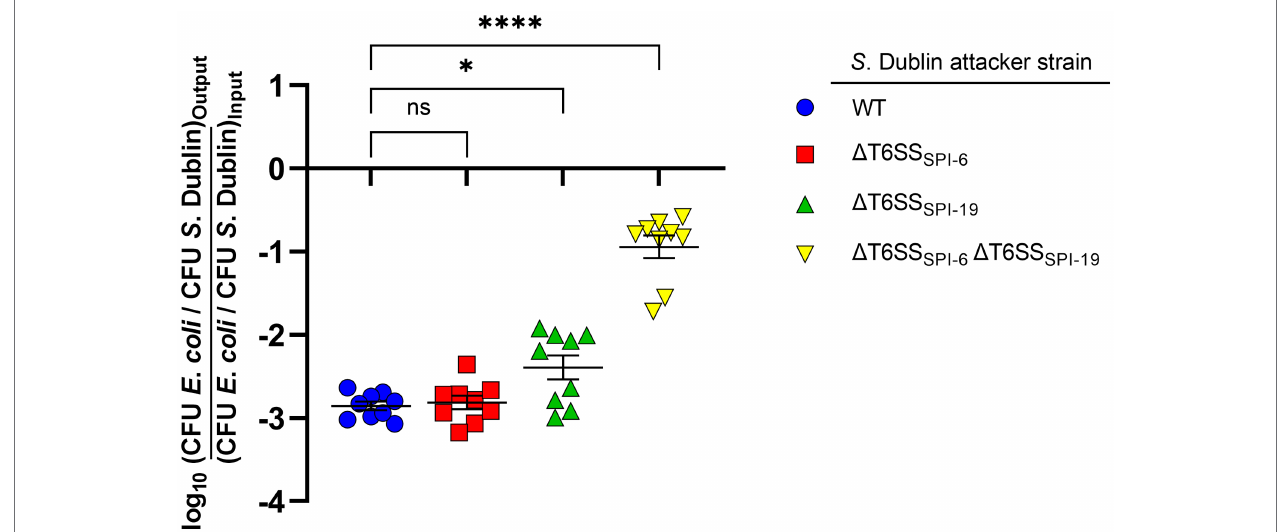
FIGURE 1 | Contribution of T6SS SPI-6 and T6SS SPI-19 to interbacterial competition by S. Dublin strain CT_02021853. Wild-type and mutant strains Δ T6SS SPI-6 , Δ T6SS SPI-19 , and Δ T6SS SPI-6 Δ T6SS SPI-19 of S. Dublin CT_02021853 were mixed at a ratio of 1:1 (attacker/prey) with Escherichia coli DH5 α . Then, 25 μ l of the mixture was incubated at 37 ° C for 24 h in triplicate on MacConkey agar plates. Bacterial counts recovered from each competition assay were calculated by plating serial 10-fold dilutions on LB agar plates with the appropriate antibiotics (Nal in the case of E. coli and Kan or Cam in the case of S. Dublin strains). Data show the ratio of E. coli CFU (prey) to S. Dublin CFU (attacker) normalized to the inoculum ratio and expressed as log 10 . Error bars indicate standard error. Statistical significance was determined using a one-way ANOVA followed by Tukey’s multiple comparisons test (* p < 0.05; **** p < 0.0001; ns, not